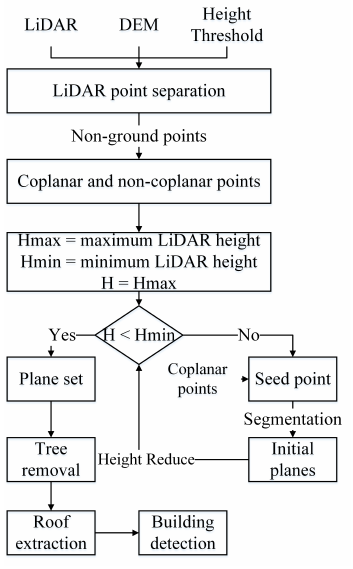
Figure 2: Flow diagram of the proposed